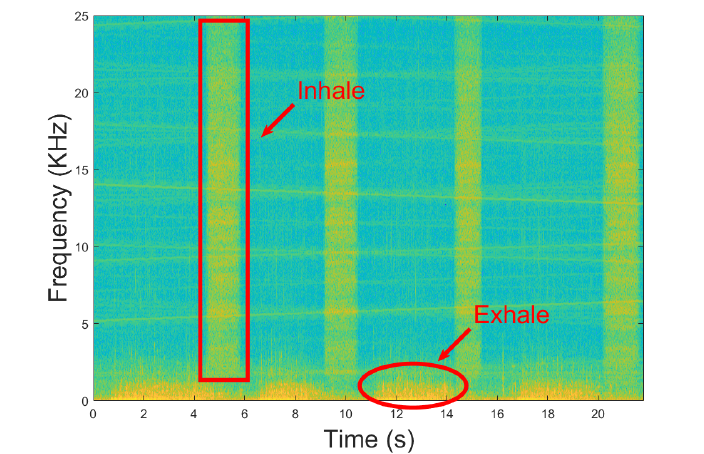
Figure 6. The spectrum of the diver’s breathing sound. Inhaling sound frequency distributes in 2 kHz–25 kHz when sample rate is 50 kHz and exhaling sound frequency power is below 2